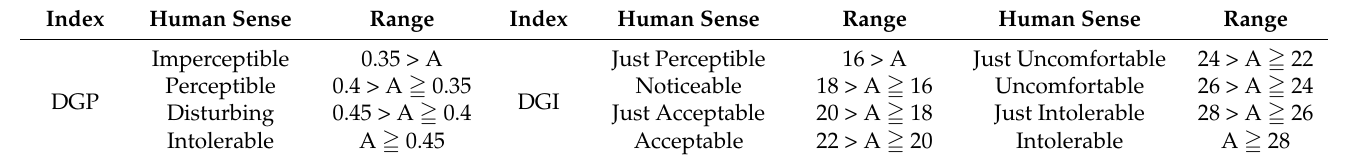
Table 2. Comfort criteria of DGP and DGI (Adapted from Ref.